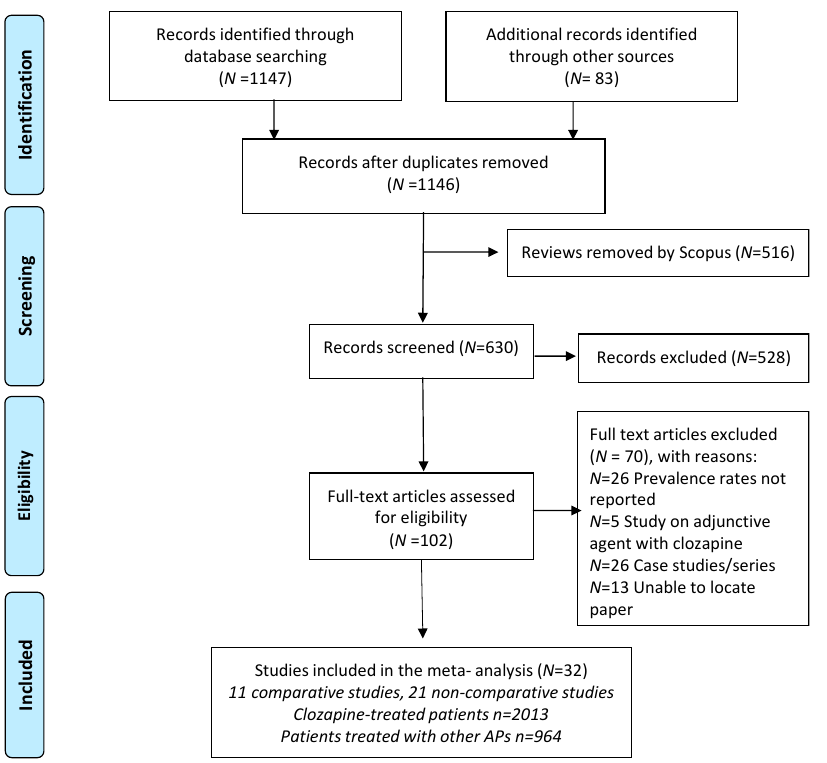
Figure 1. Flow diagram of article search and review process.